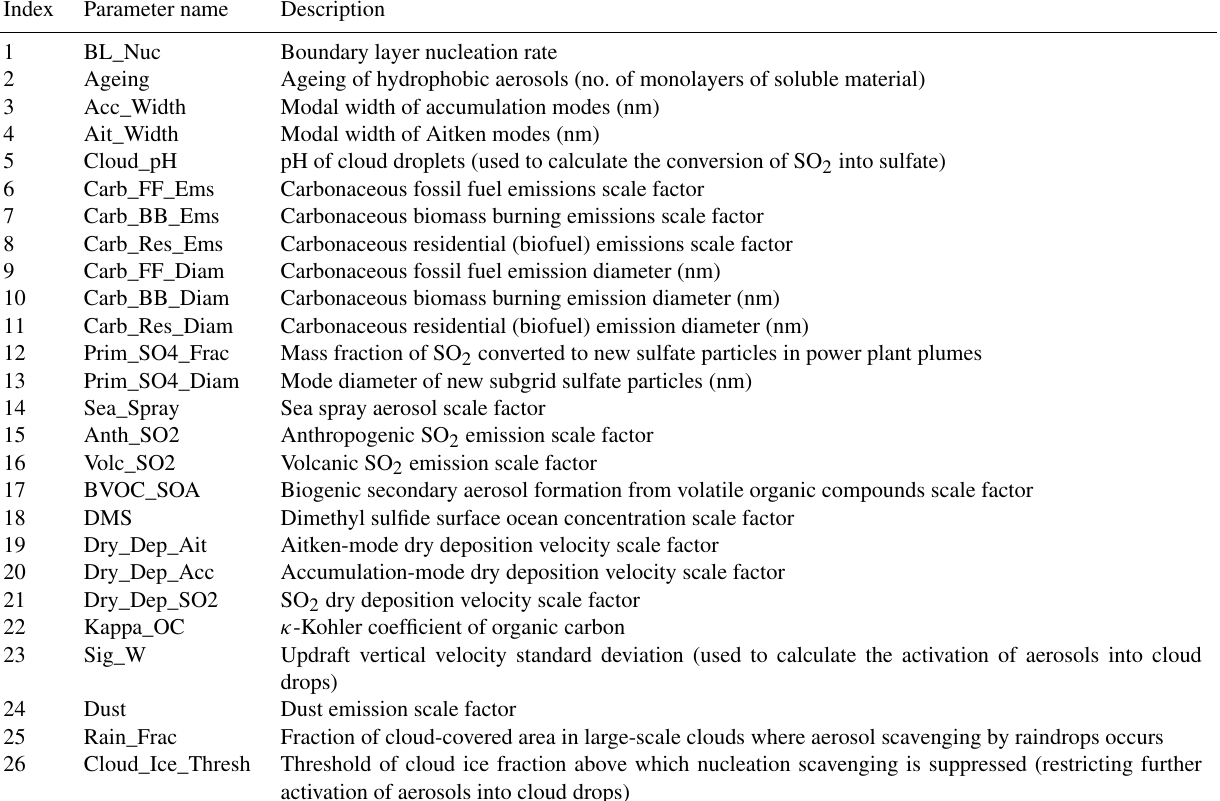
Table A1. The 26 aerosol parameters included in the AER PPE. Further details are provided in a separate publication (Yoshioka et al.,